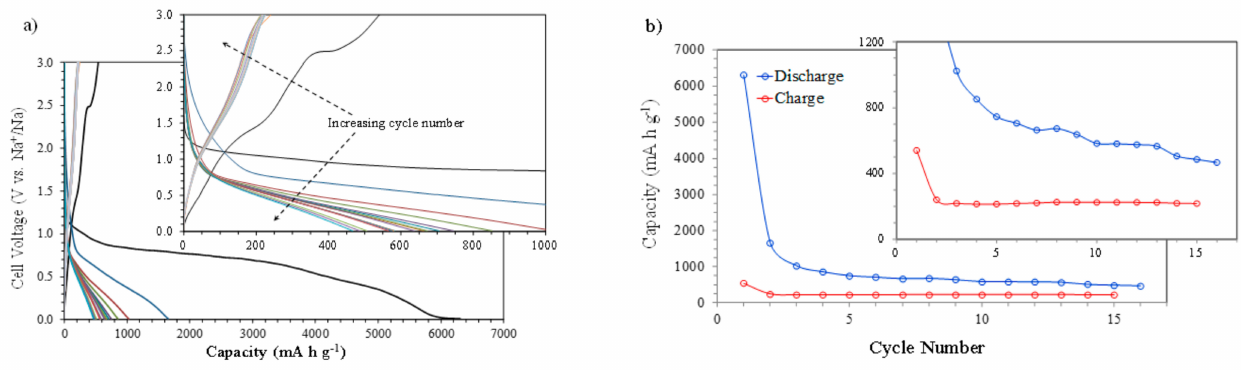
Figure 4. The electrochemical characterization of NiO films at a current intensity of 400 mA g − 1 : ( a ) discharge–charge profiles (capacity vs. cell voltage) and ( b ) discharge and charge capacities vs. cycle number.